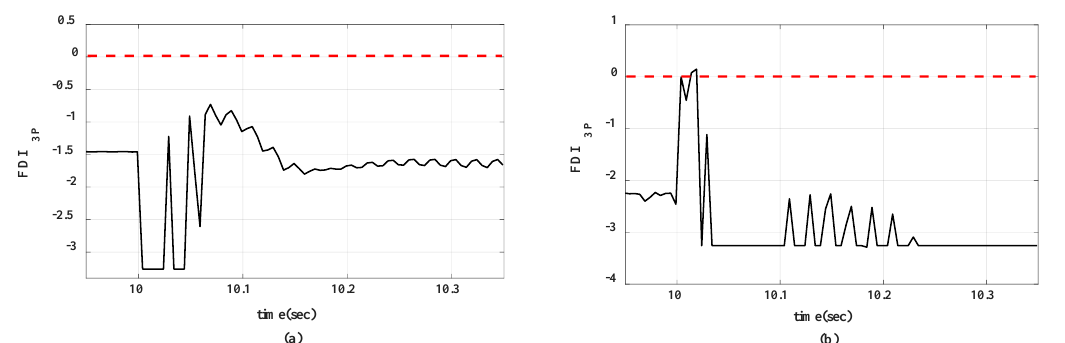
Figure 16. FDI 3P for load change at bus E in ( a ) grid-connected mode (negative) ( b ) islanded mode (transiently positive).